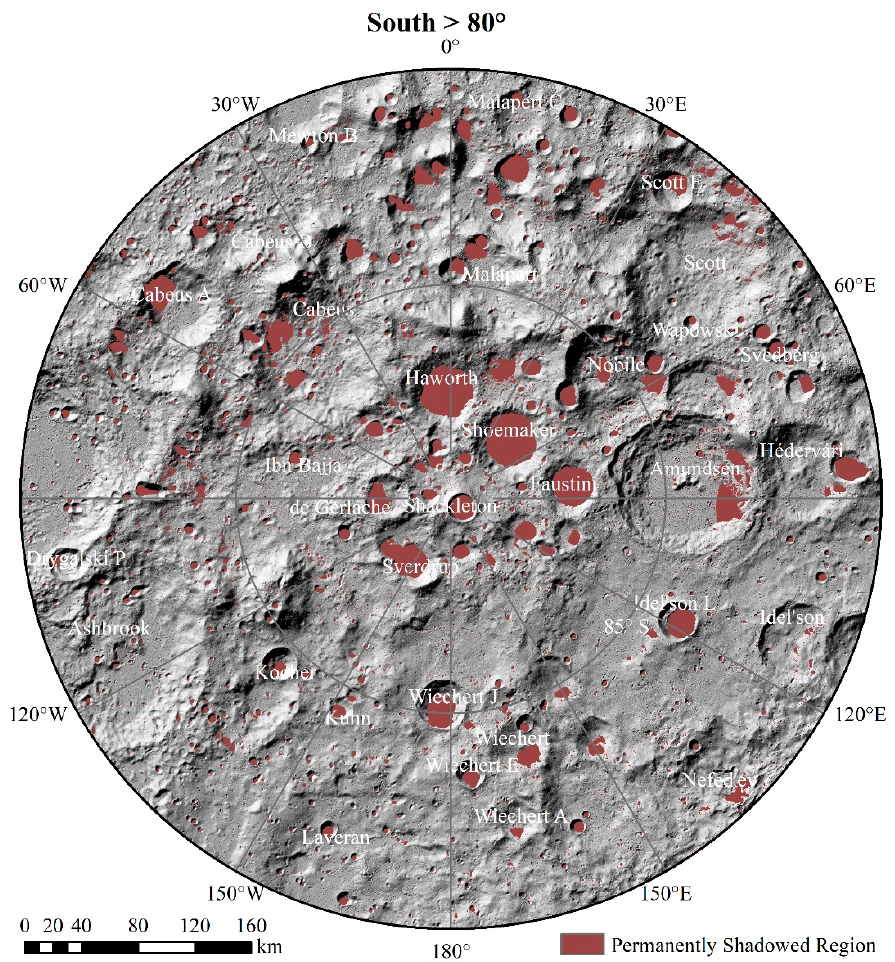
Figure 12. Permanent shadowing area at the south pole of the Moon. The base image is LOLA digital elevation data at the south pole with a resolution of 20 m. (The south polar PSR covers 16,055 square kilometers with thousands of small and large regions).